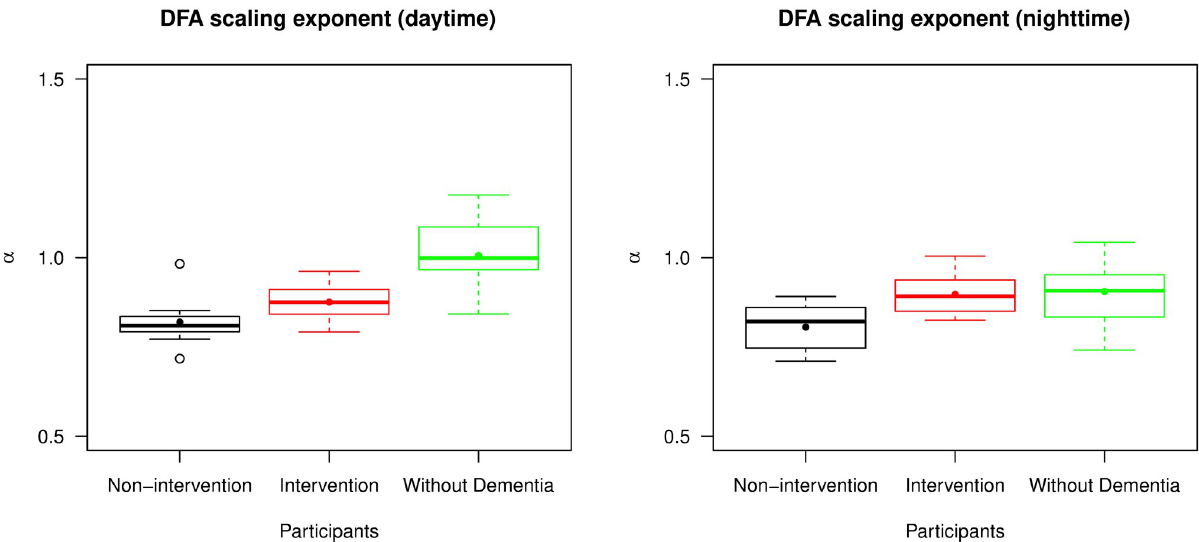
Fig 8. Distribution of DFA scaling exponents ( α ) from daytime and nighttime readings. The left panel is a box plot collating α values from daytime readings and the right panel is a box plot collating α values from nighttime readings across the non-intervention group, the intervention group, and the group of individuals without dementia. For each group and type of readings, the median and mean of the α values are presented by a thick line and a point in its own box, respectively.